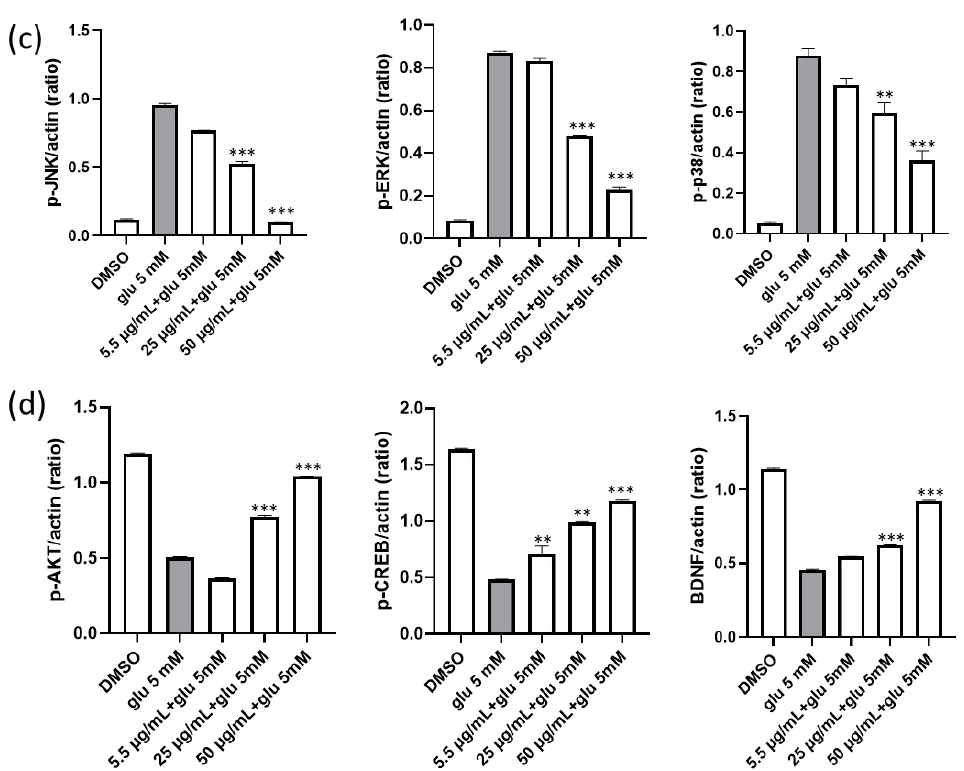
Figure 5. The 75% EEPF regulates MAPK activation and PI3K/AKT/CREB. ( a ) Protein expression levels of p-JNK, JNK, p-ERK, ERK, p-p38, and p38. ( b ) Protein expression levels of p-AKT, AKT, p-CREB, CREB, BDNF, and pro-BDNF. The glutamate and 75% EEPF was treated for 8 hrs and western blot was performed. ( a ) The 75% EEPF co-treatment inhibited p-JNK, p-ERK, and p-p38 protein level. ( b ) The 75% EEPF co-treatment rescued the p-AKT, p-CREB, and pCREB proteins levels. ( c ) and ( d ) Bar graphs of the intensity of immunoblot bands visualized using the image J software. Data presented as the mean ± standard deviation (SD) of two independent experiments. *** p < 0.001, ** p < 0.01 vs. the glu 5 mM group.